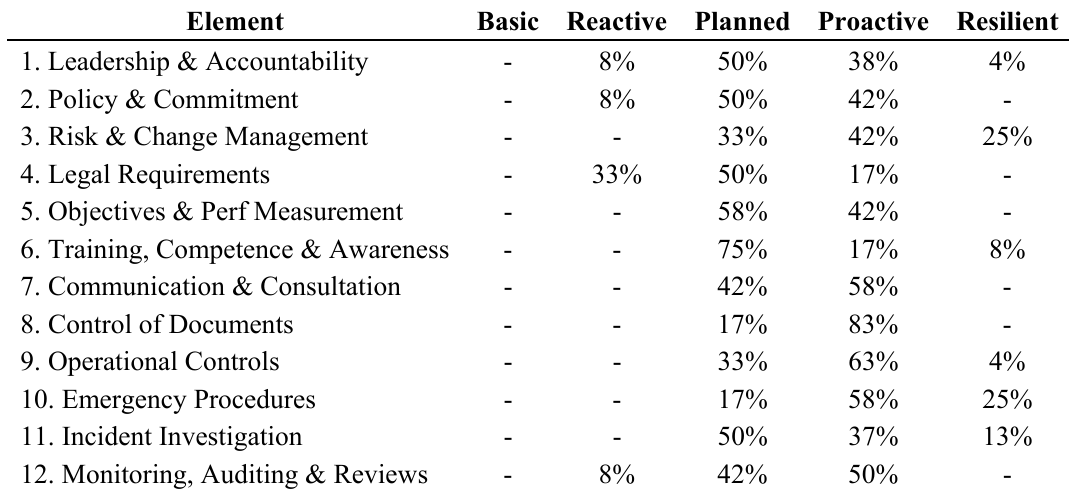
Table 4. Analysis of results from the deep